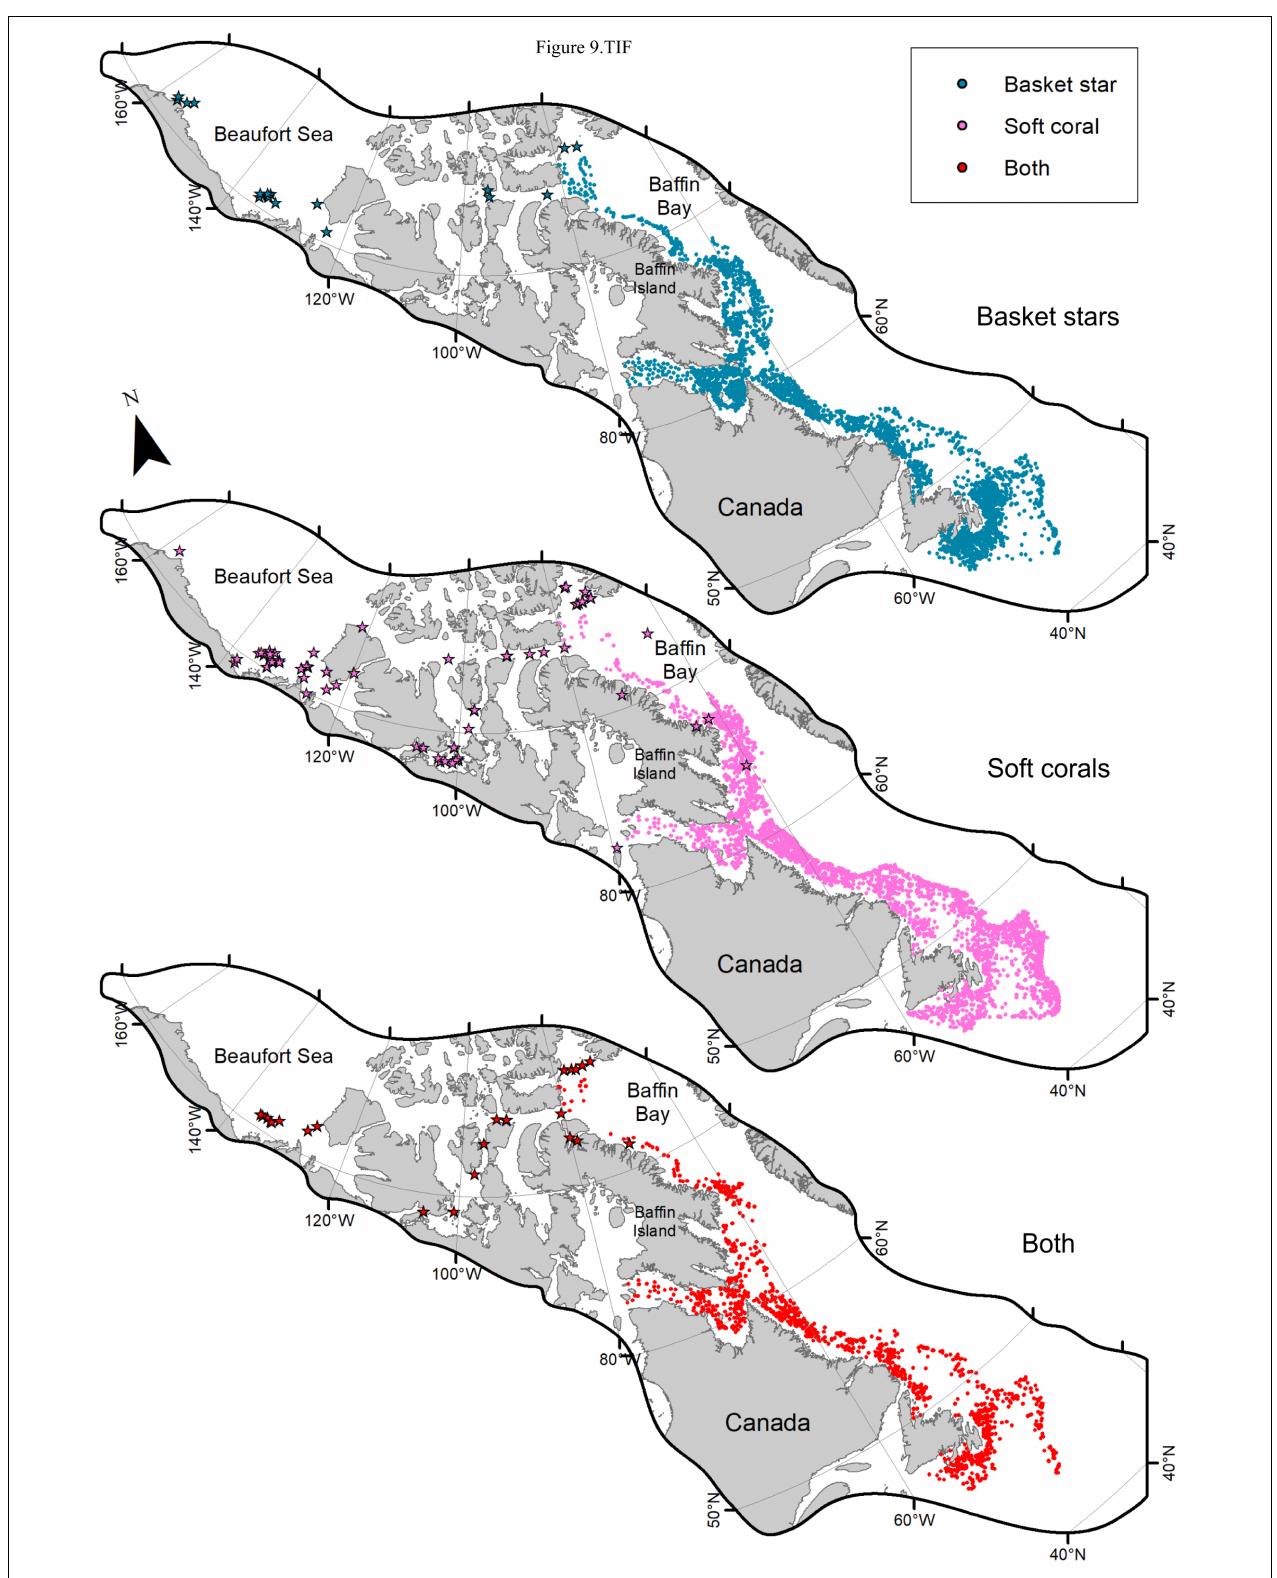
FIGURE 9 | Trawl data on presence of basket stars, Nephtheidae soft corals, and both per trawl set (2011–2017). Dots represent DFO RV trawl surveys, while stars represent Agassiz trawl surveys. The maps were cropped to limit the view to the distribution of samples.